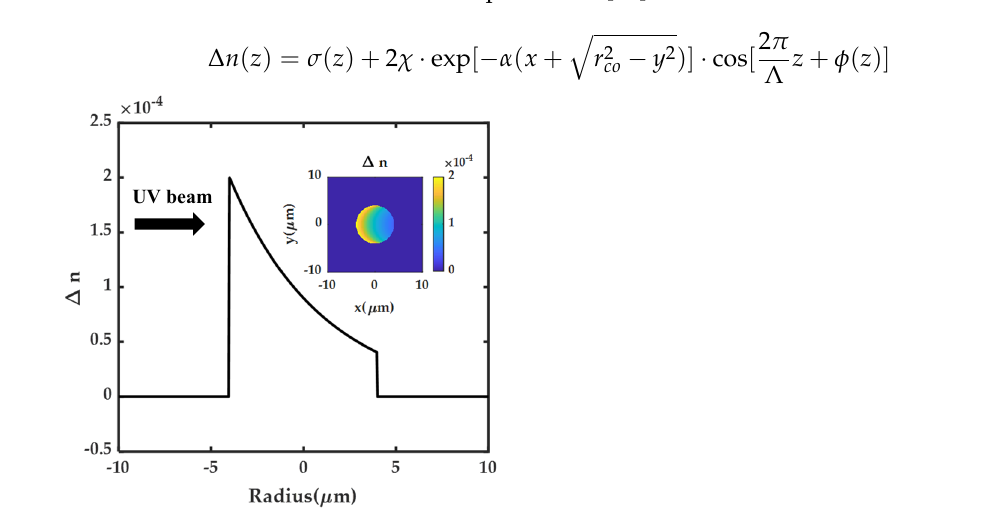
Figure 2. Asymmetric refractive index modulation by UV single-side illumination.